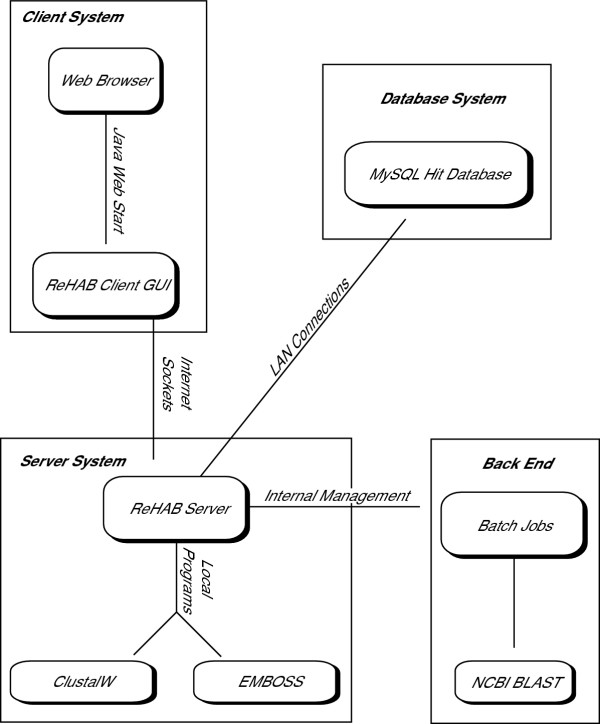
Organization of ReHAB processing steps. ReHAB is set up as four main components: the client, the Hits Database, the server and the back end. See text for details.